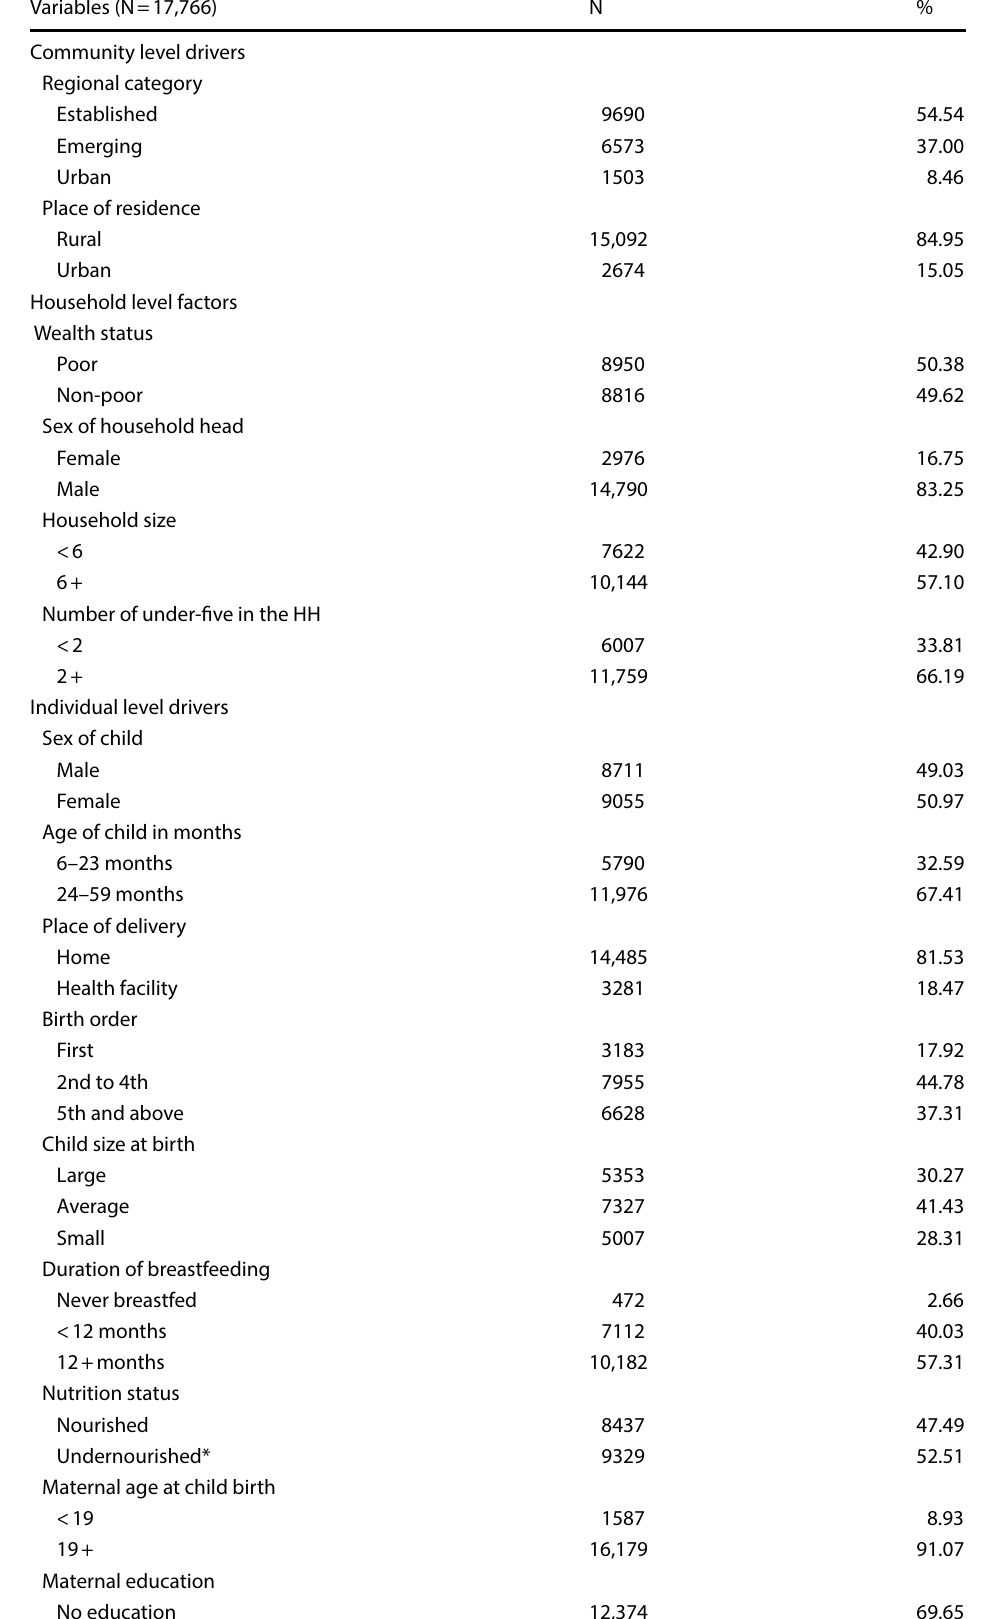
Table 1 Background characteristics of the study participants, Ethiopia,